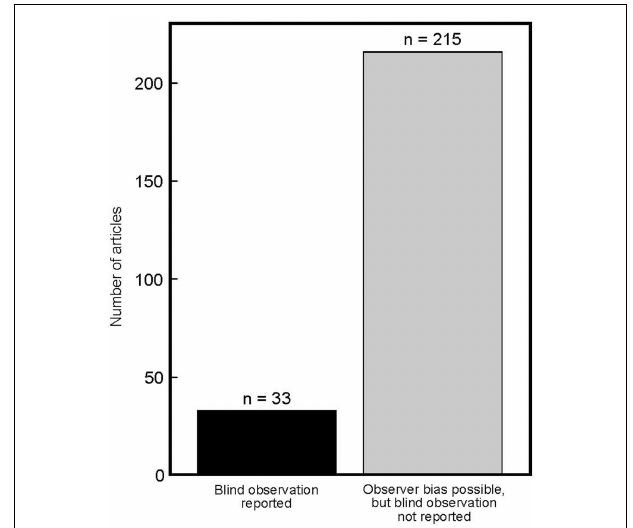
FIGURE 1 | Of 492 articles published in January and February 2012 in 13 prominent journals covering the fields of ecology, evolution, and behavior (EEB), 248 articles reported on experiments that had potential for observer bias. Only 13.3% ( n = 33 of 248) of these articles stated the use of blinding in the methods. The remaining 244 articles were judged unlikely to be affected by observer bias (see Figure S1). The use of blind observation therefore was either grossly underreported in the surveyed articles, studies had not been blinded, or a combination of